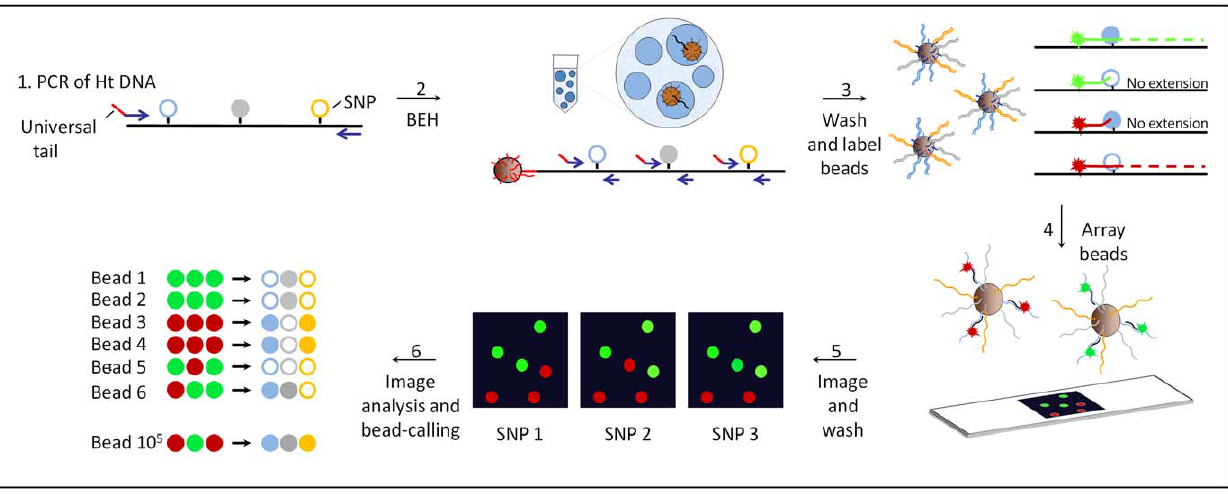
Figure 1. Schematics of bead-emulsion haplotyping (BEH). In step 1, a region of several kilobases containing several polymorphic sites is amplified from genomic DNA heterozygous for the tested SNPs. In step 2, single amplicons are hybridized to microscopic beads covered with a primer that has a universal tail common to the 5 9 end of the multiplexing primers (shown in red). PCR products from 3 small regions containing the polymorphisms are produced within the aqueous compartment of an emulsion droplet and bound to the bead. In step 3, the beads are washed and labeled by allele-specific extensions of fluorescent probes specific for one of the polymorphic sites. In step 4, unextended probes are washed off and the fluorescent beads are arrayed on a slide. In step 5, the array is scanned with a microscope followed by subsequent washing, probing and imaging cycles to screen additional polymorphisms (up to 4 different alleles; 2SNPs can be analyzed simultaneously). In step 6, a series of imaging and data analysis steps are performed to assess the initial haplotype of , 10 5